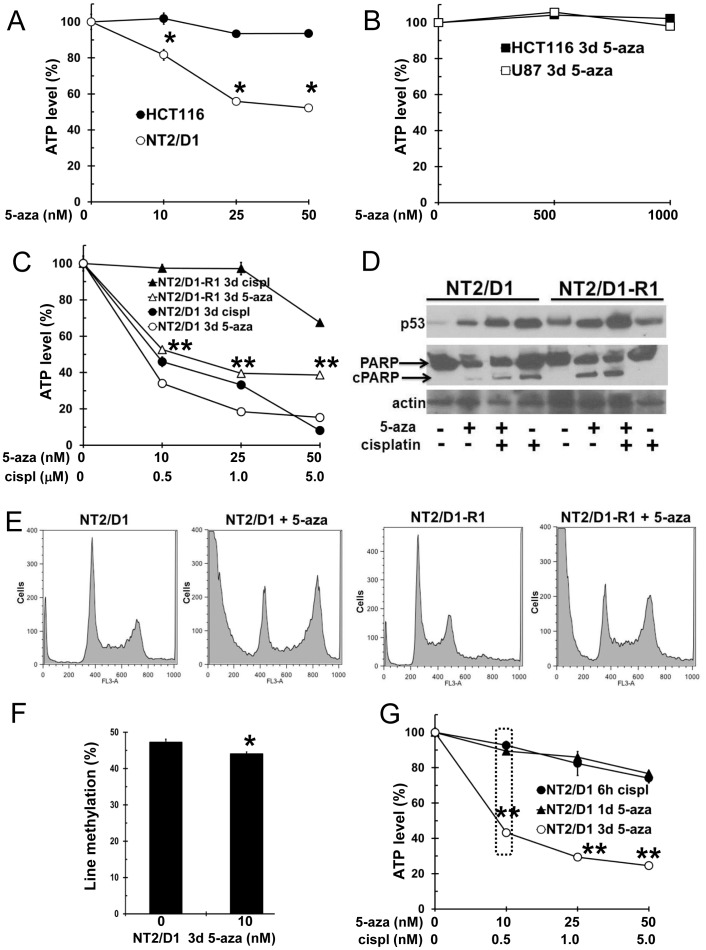
Low-dose 5-aza induces an acute death response in cisplatin sensitive and resistant EC cells.
A–B, The EC line NT2/D1 but not colon cancer HCT116 cells or glioblastoma U87 cells are sensitive to low-dose 5-aza. 5-aza was added for 3 days to exponentially growing cultures. Viable cell growth and survival were measured. C, Cisplatin resistant NT2/D1-R1 cells remain sensitive to low-dose 5-aza. NT2/D1 and NT2/D1-R1 cells were treated with cisplatin for 6 hours and assayed 3 days later or 5-aza was added for 3 days. D, 5-aza induces p53 protein and induces cell death in NT2/D1 and NT2/D1-R1 cells while cisplatin induces p53 protein and cell death only in NT2/D1 cells. Cell were treated with 10 nM 5-aza for 3 days or 1.0 µM cisplatin for 12 hours or the combination and Western analysis performed for p53 and PARP. The arrow indicates cleaved 85 KD PARP that is indicative of apoptosis. E, Treatment with 5-aza results in cell death and G2 cell cycle arrest in NT2/D1 and NT2/D1-R1 cells. Cells were treated with 10 nM 5-aza for 3 days. Substantial cells in subG1 are indicative of cell death. F, Low-dose 5-aza induced global demethylation in NT2/D1 and colon cancer HCT116 cells. Cells were treated with the indicated does of 5-aza for 3 days and methylation of LINE-1 elements were measured by DNA bisulfite-pyrosequencing. G, Viable cell growth and survival of treatment protocols for subsequent expression array analysis. NT2/D1 cells were treated with indicated doses of 5-aza added for 1 or 3 days before harvest or indicated doses of cisplatin for 6 hours follows by 24 hour harvest. Dotted box indicates cell treatments used for expression arrays. All bars and data points are the average of biological triplicates. Error bars are standard deviation and are within the size of the symbols in most cases. * = p<0.05; ** = p<0.005 compared to untreated controls.